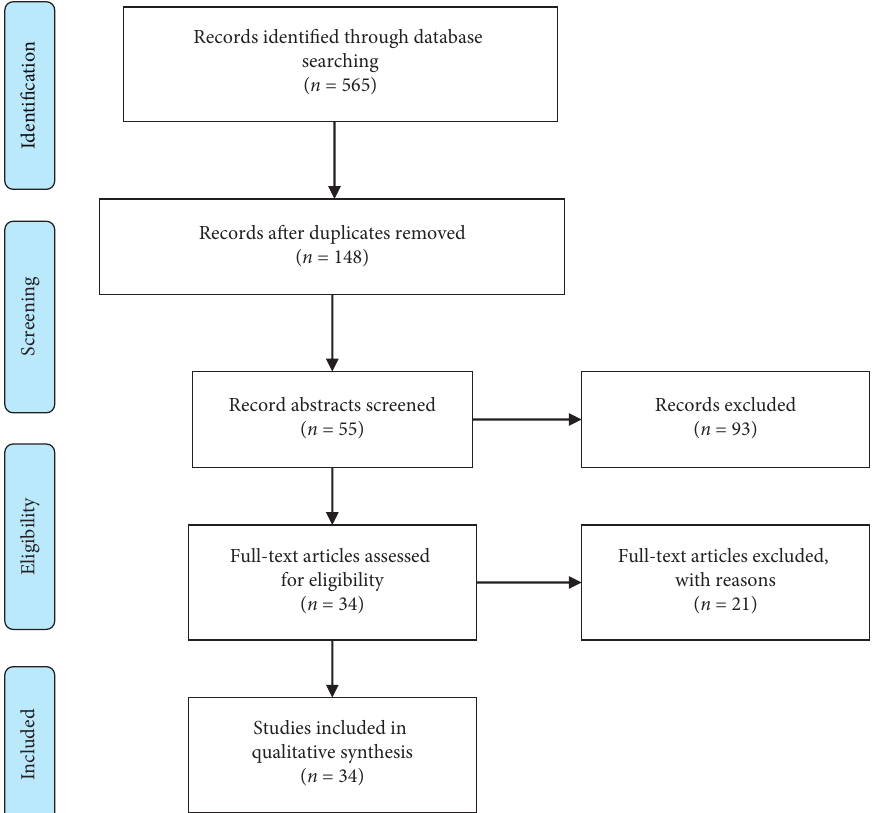
Figure 1: PRISMA flowchart of summary (Supplementary Table S2), (3) pain associated with trauma and neuralgias [8, 11, 16, 42] (Supplementary Table S3), (4)